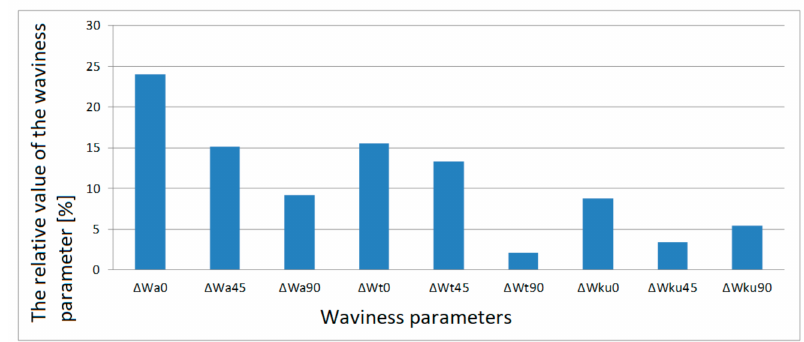
Figure 7. Relative values of frontal surface waviness parameters for each print orientation.